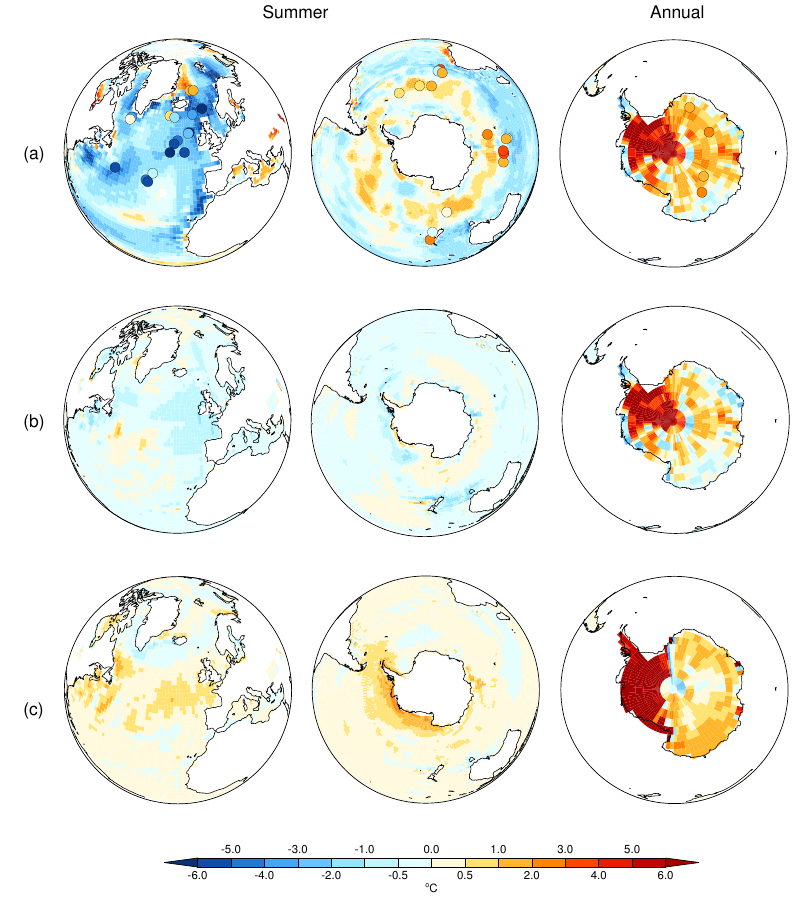
Figure 8. (a) Simulated 130ka SST and near-surface air temperature anomalies, with the WAIS removed and replaced with bare soil and a North Atlantic freshwater input forcing of 0.2Sv, compared with the Capron et al. (2014) 130ka time slice. (b) Difference in SST and near-surface air temperature between (a) and the 130ka simulation with 0.2Sv freshwater forcing only (Fig. 4c). (c) Difference in SST and near-surface air temperature when the WAIS is replaced with shrub rather than bare soil (Fig. 8a). Left: summer-SST anomalies for the NH (July, August, and September); middle: summer-SST anomalies in the SH (January, February, and March); right: annual near-surface air temperature anomalies over Antarctica. It has been shown that this warming over East Antarctica is attributed to climatic effects rather than isostatic effects arising from a reduction in the WAIS (Bradley et al.,